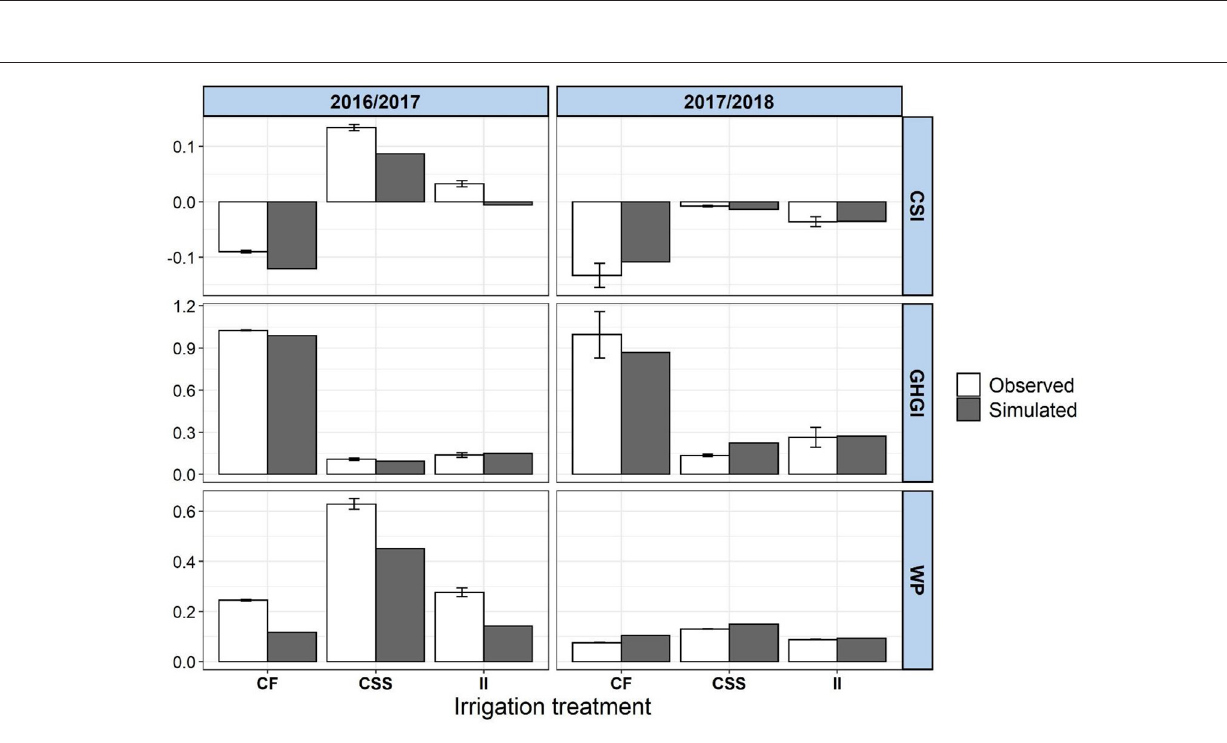
FIGURE 2 | Observed (white bars) and simulated (gray bars) data of Water productivity (WP; kg/m 3 ); Greenhouse Gas Intensity (GHGI; kg CO 2 -eq kg grain − 1 ); Climate-Smartness Index (CSI) for the Continuous flooding (CF), Intermittent Irrigation (II) and Continuous Soil Saturation (CSS) for the seasons 2016/2017 and 2017/2018. Error bars represent the standard